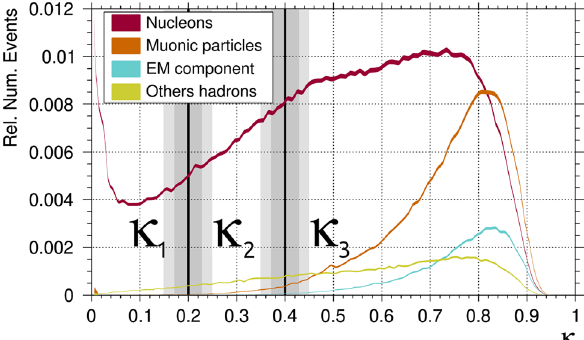
Fig. 1 EPOS-LHC’s inelasticity distributions for each leading particle family. The two shaded regions indicate the systematic uncertainties in the definition of κ due to event-by-event fluctuations in the amount of energy violation